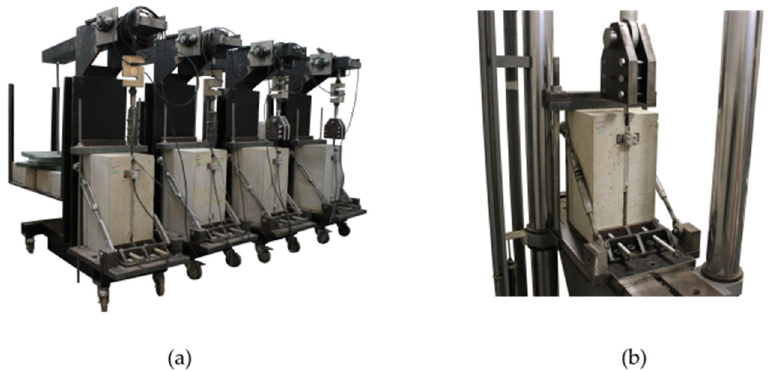
Figure 2. Set ‐ up used for ( a ) sustained loading tests; ( b ) post ‐ sustained loading tests. Figure 2. Set-up used for ( a ) sustained loading tests; ( b ) post-sustained loading